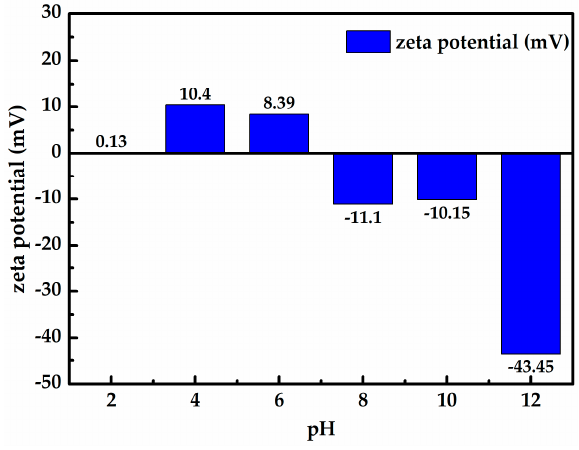
Figure 2. Relationship between zeta potential of the Longtan coal surface and pH. Table 4. Effect of different dispersions on the surface zeta potential of coal.